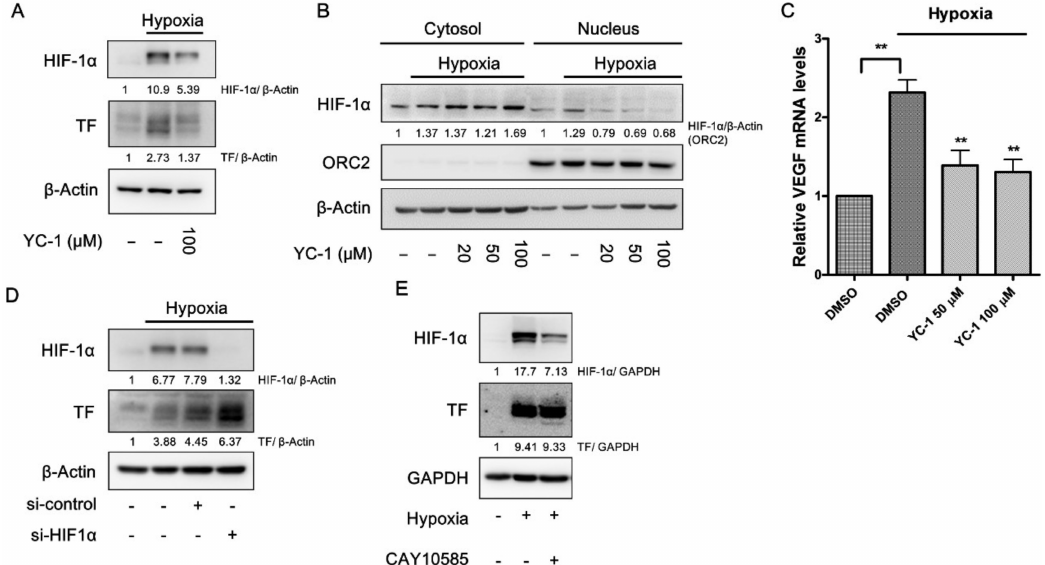
Figure 3. YC-1 inhibits hypoxia-induced TF via a HIF-1 α -independent manner in A549 cells. ( A , B ) YC-1 inhibits HIF-1 α accumulations and decreases HIF-1 α nuclear translocation in response